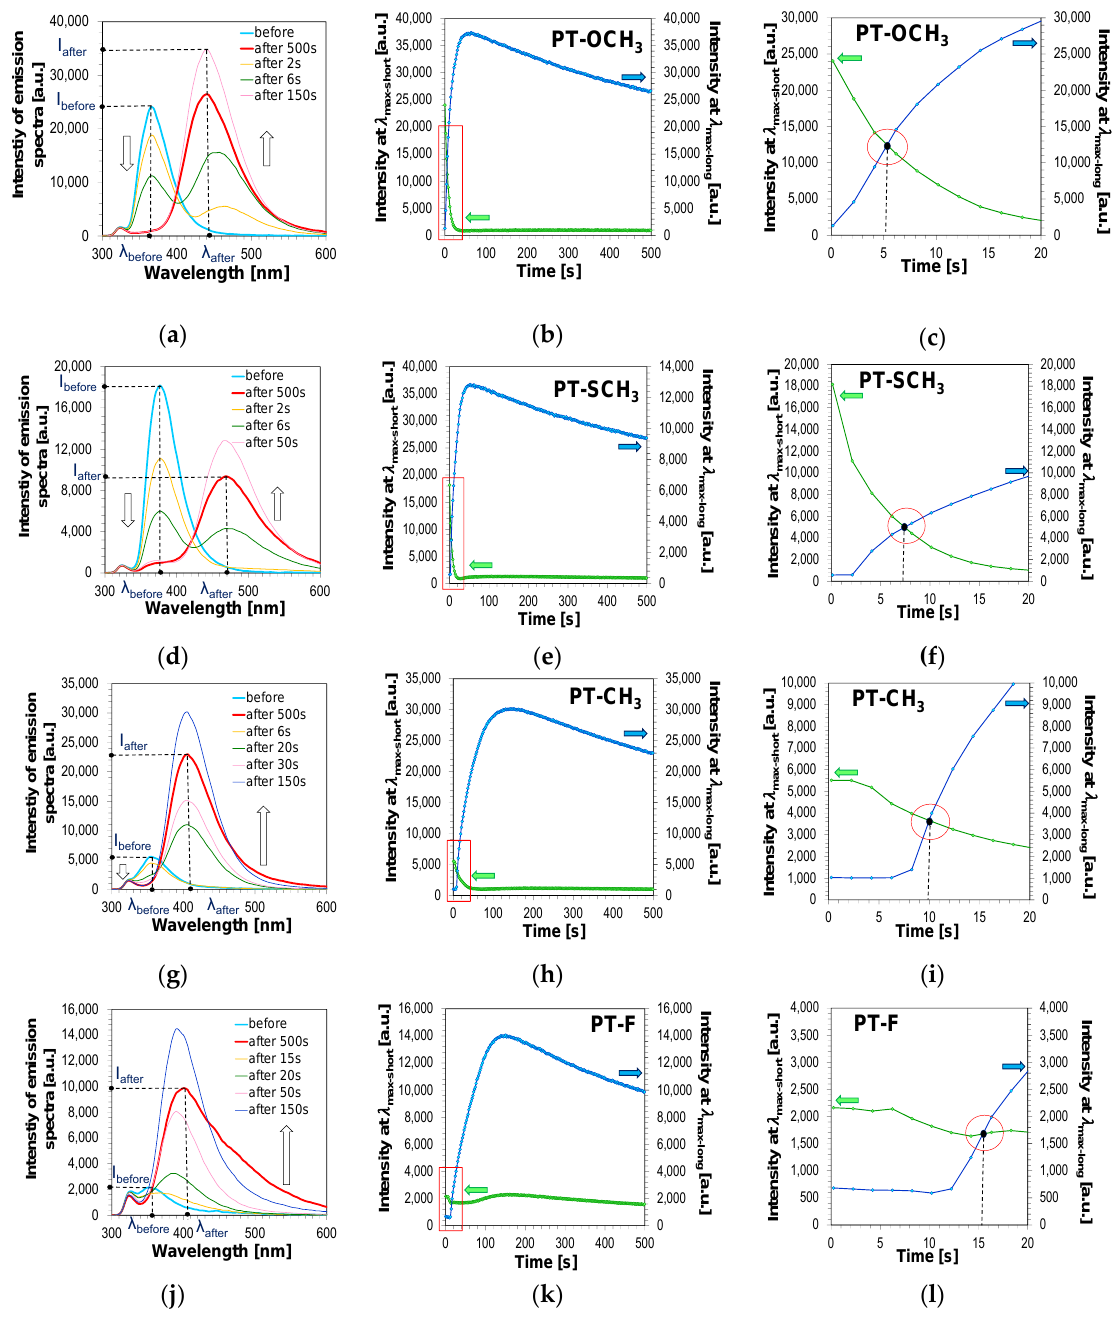
Figure 9 . ( a,d,g,j ) Changes of fluorescence spectra of the 2,6-diphenylpyridine derivatives during cationic photopolymerization of TEGDVE monomer under irradiation at 320 nm; ( b,c,e,f,h,i,k,l ) monitoring cationic photopolymerization of TEGDVE monomer under 320 nm by FPT, using the 2,6-diphenylpyridine derivatives as the fluorescent sensors.